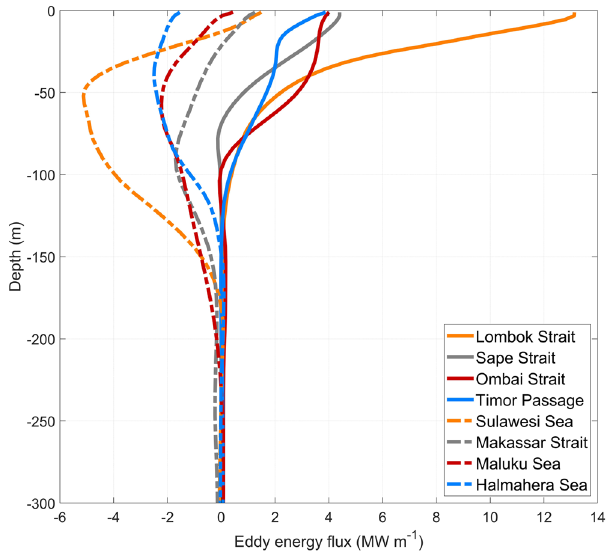
Fig. 4 | Vertical pro fi les oftime-averaged, horizontally-integrated eddy energy fl uxes in (MWm − 1 ; 1MWm − 1 =10 6 Wm − 1 ) across major straits and passages. Fluxes on the Indian Ocean side are shown by solid lines and fl uxes on the Paci fi c Ocean side are shown by dashed